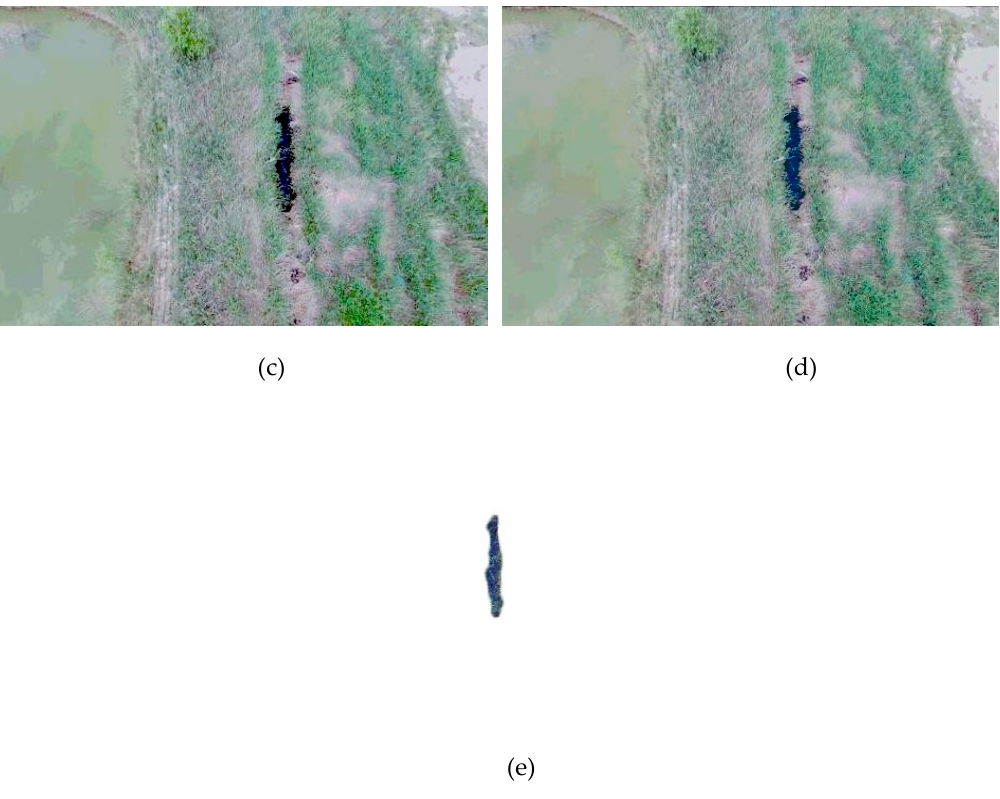
Figure 18. The segmentation results of oil pollution2 image. ( a ) 3DPCNN-HSOA; ( b ) LSA; ( c ) MS; ( d ) GLCM; and ( e ) Ground truth.